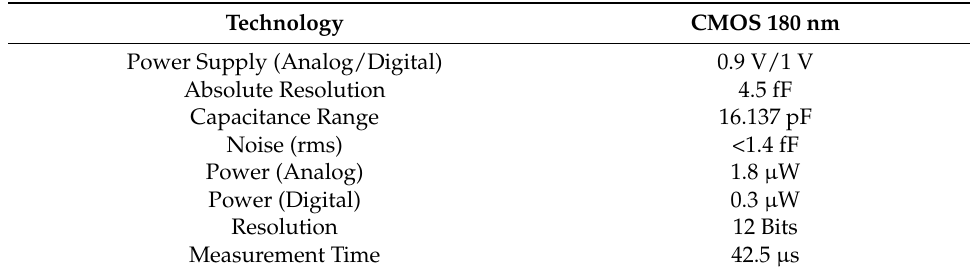
Table 2. Comparison to some of the pre-existing biosensor-CMOS platforms.